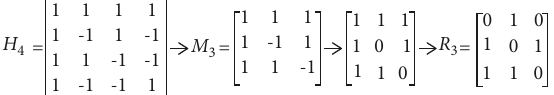
Figure 3: An example of standard Hadamard matrix H transforming into R q ( 0 < q < 4 k